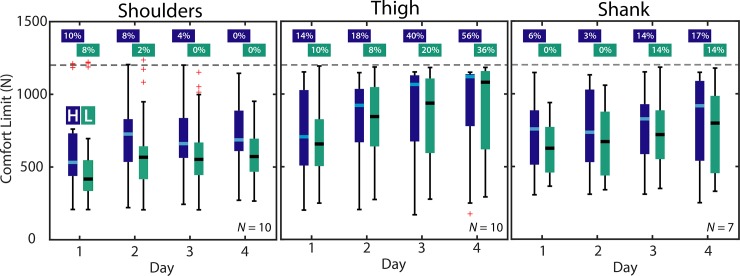
Effect of force rate on comfort limits.Boxplots depict group results for each force rate across days. High force rate results are in dark blue (“H”), and low force rates are depicted in light green (“L”). Percentage of trials that reached the maximum approved force limit are depicted above each column. The 1200 N maximum approved force is denoted with a dashed gray line.